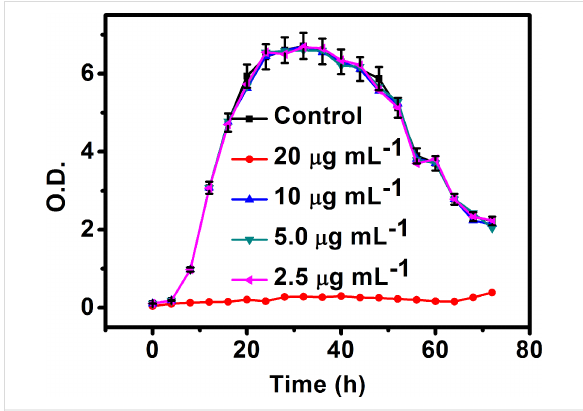
Figure 6: Cytotoxicity towards the bacteria Xag after incubation with S b in the concentration range 2.5–20 µg mL − 1 for 72